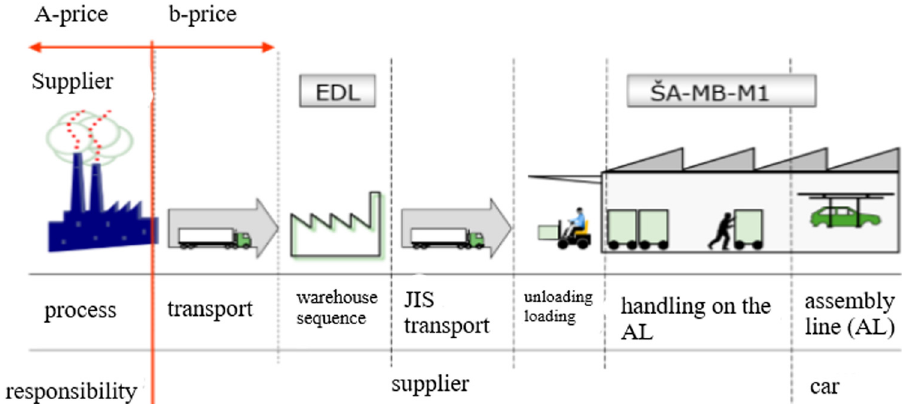
Figure 5: JIS B diagram. Source: ref. [ 14 ]